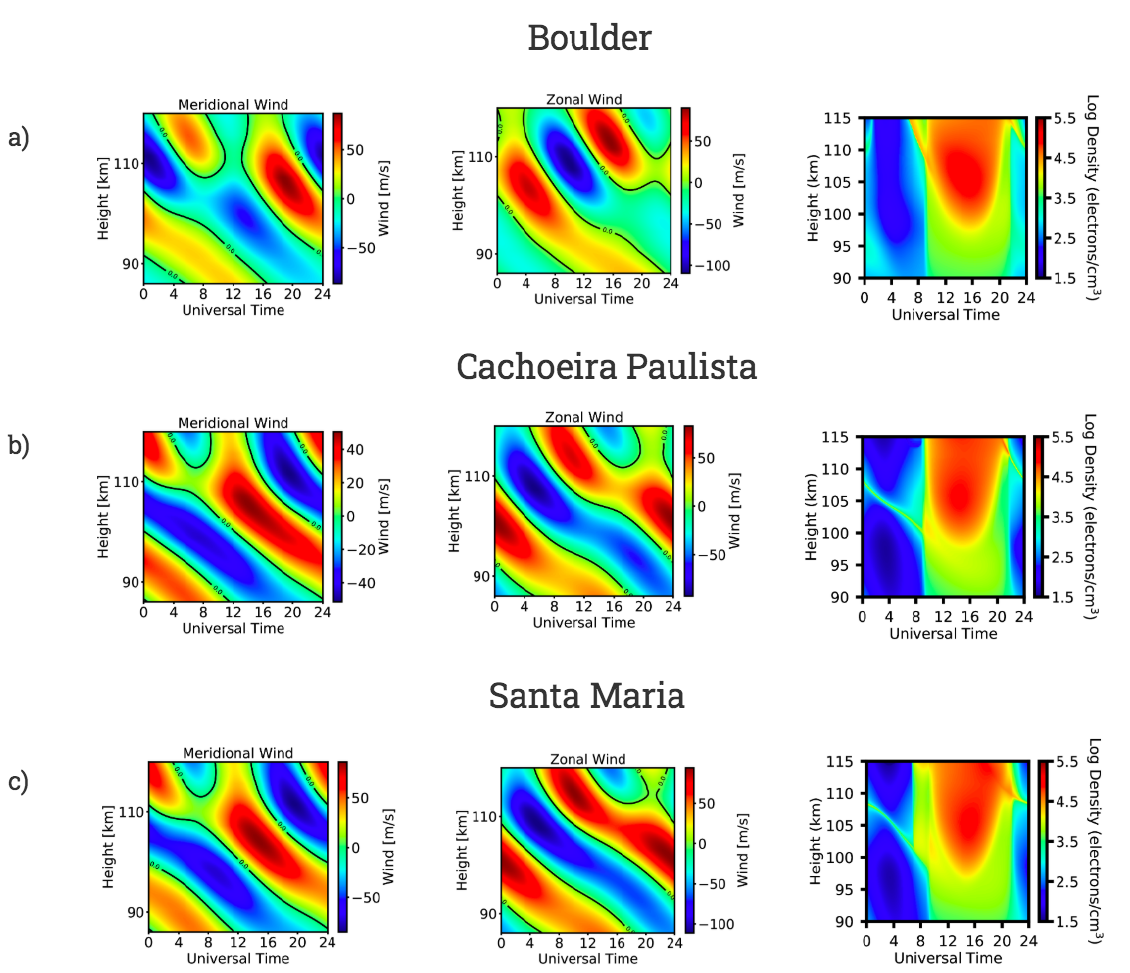
Figure 6. Wind profile of the meridional (left panel) and zonal (middle panel) components obtained using GSWM and electron density (right panel) as a function of Universal Time (UT) and height (km) simulated by MIRE considering the diurnal and semidiurnal tidal winds representative of September 2017 for: ( a ) Boulder; ( b ) Cachoeira Paulista; and ( c ) Santa Maria.